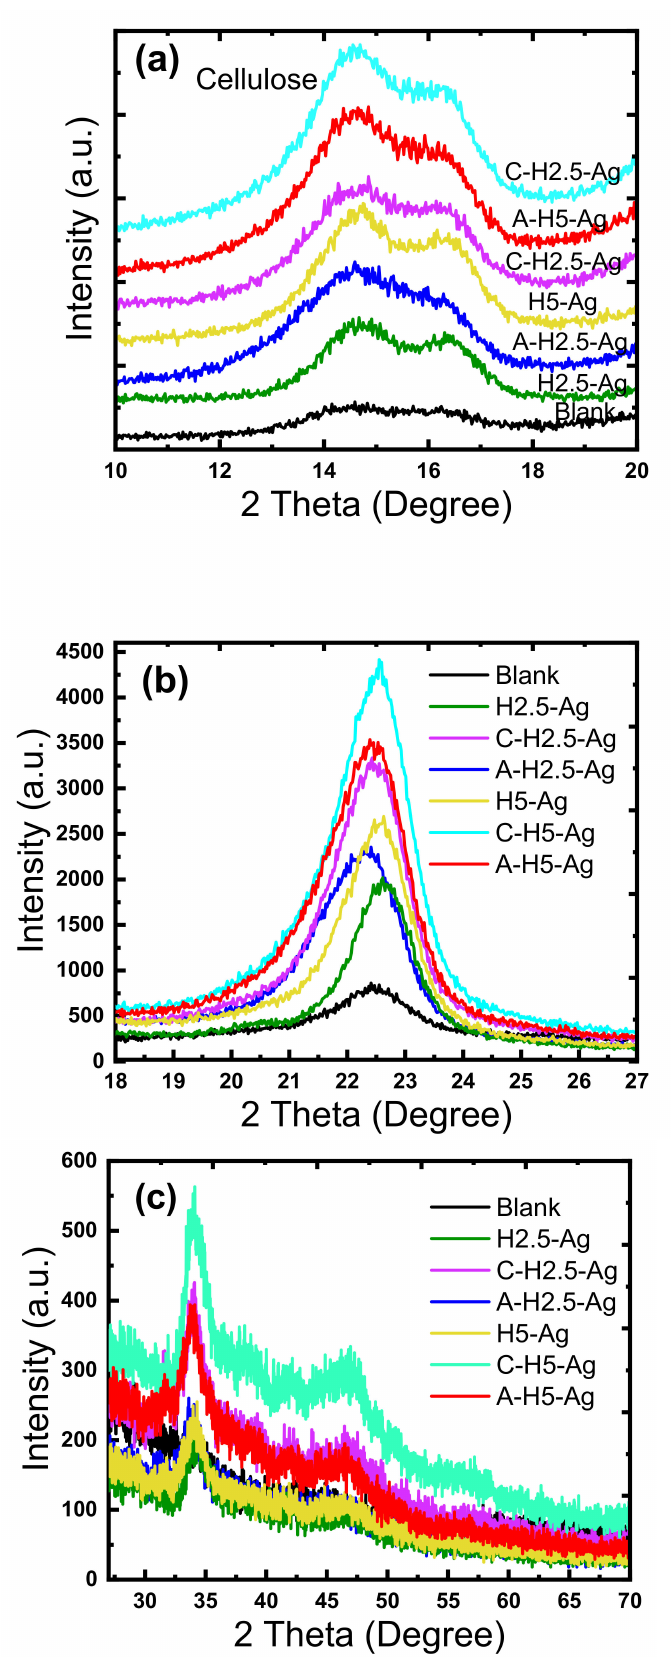
Figure 5. Characteristics of the X-ray diffraction (XRD) patterns of unmodified (blank) and modified cotton gauze samples at different 2 theta scale ( a – c